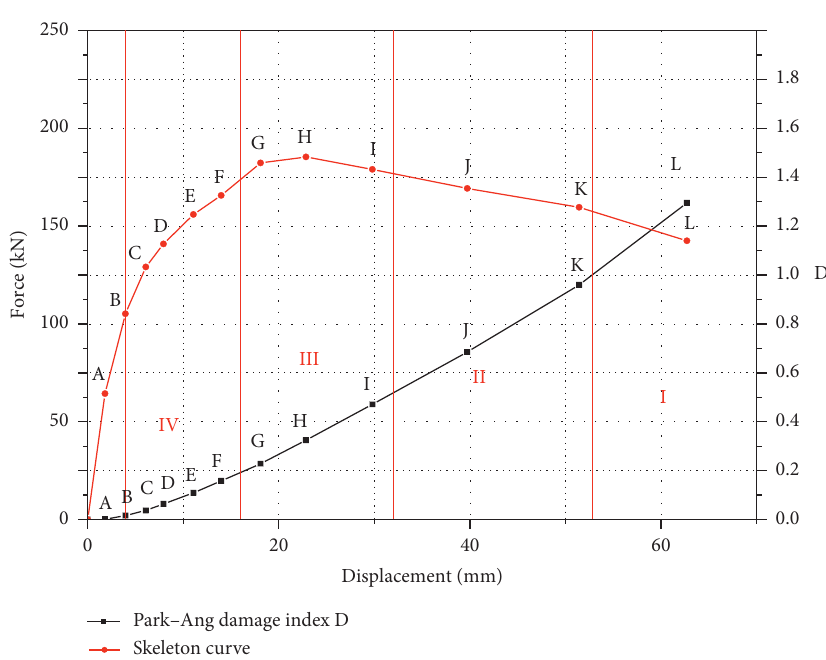
Figure 7: The correspondence between the damage indexes and the skeleton curve of